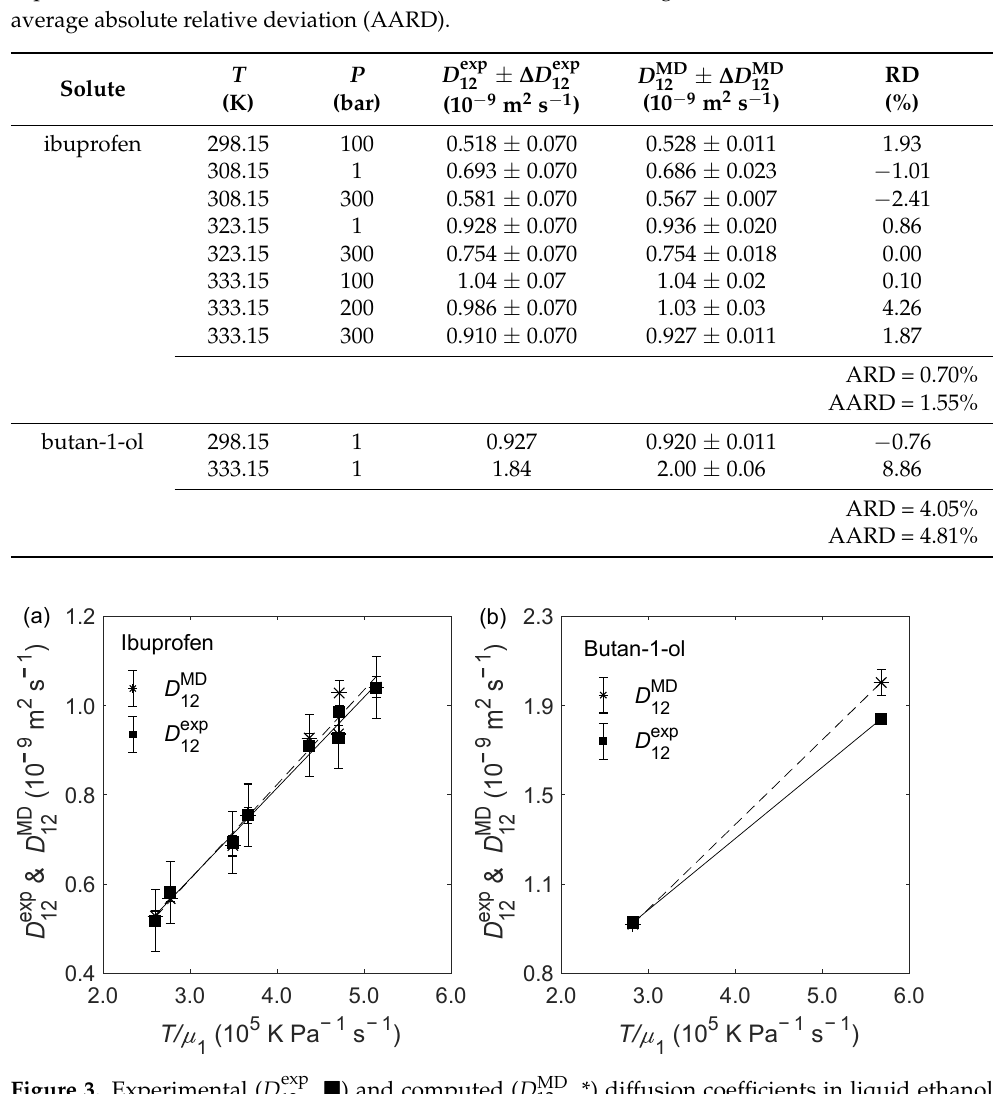
Table 2. Experimental ( 𝐷 (cid:2869)(cid:2870)(cid:2915)(cid:2934)(cid:2926) ) and computed ( 𝐷 (cid:2869)(cid:2870)(cid:2897)(cid:2888) ) diffusion coefficients of ibuprofen and butan-1- ol in liquid ethanol at various temperatures and pressures. The computer simulations used 𝜎 (cid:2899)(cid:2892) = 0.306 nm for ethanol, and the calculated diffusivities were evaluated in comparison with experimental data in terms of the relative deviation (RD), average relative deviation (ARD), and average absolute relative deviation (AARD).